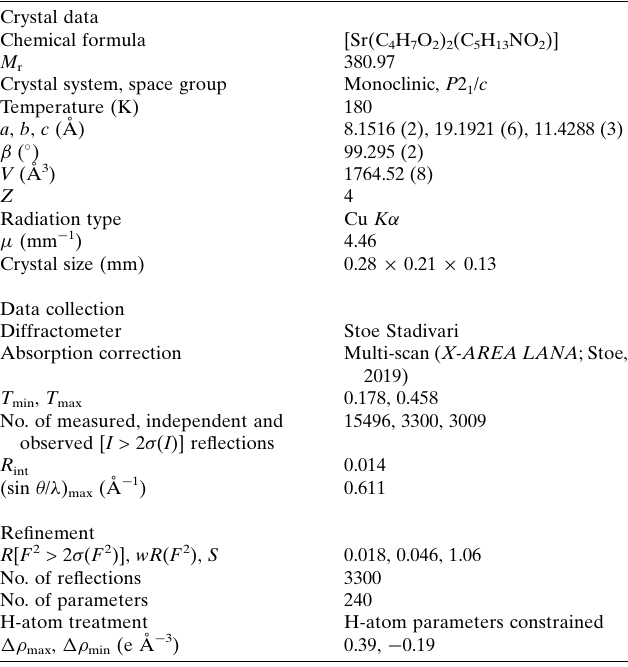
Table 4 Experimental details. Crystal data Chemical